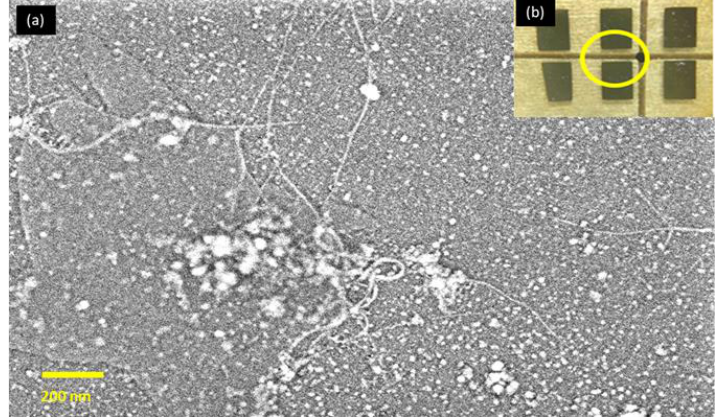
Figure 6. The surface morphology of randomly selected spot for a CoMoCAT SG 65 SWCNTs sample: ( a ) FESEM image with 50k magnification; ( b ) the yellow circle is the scan location on the substrates